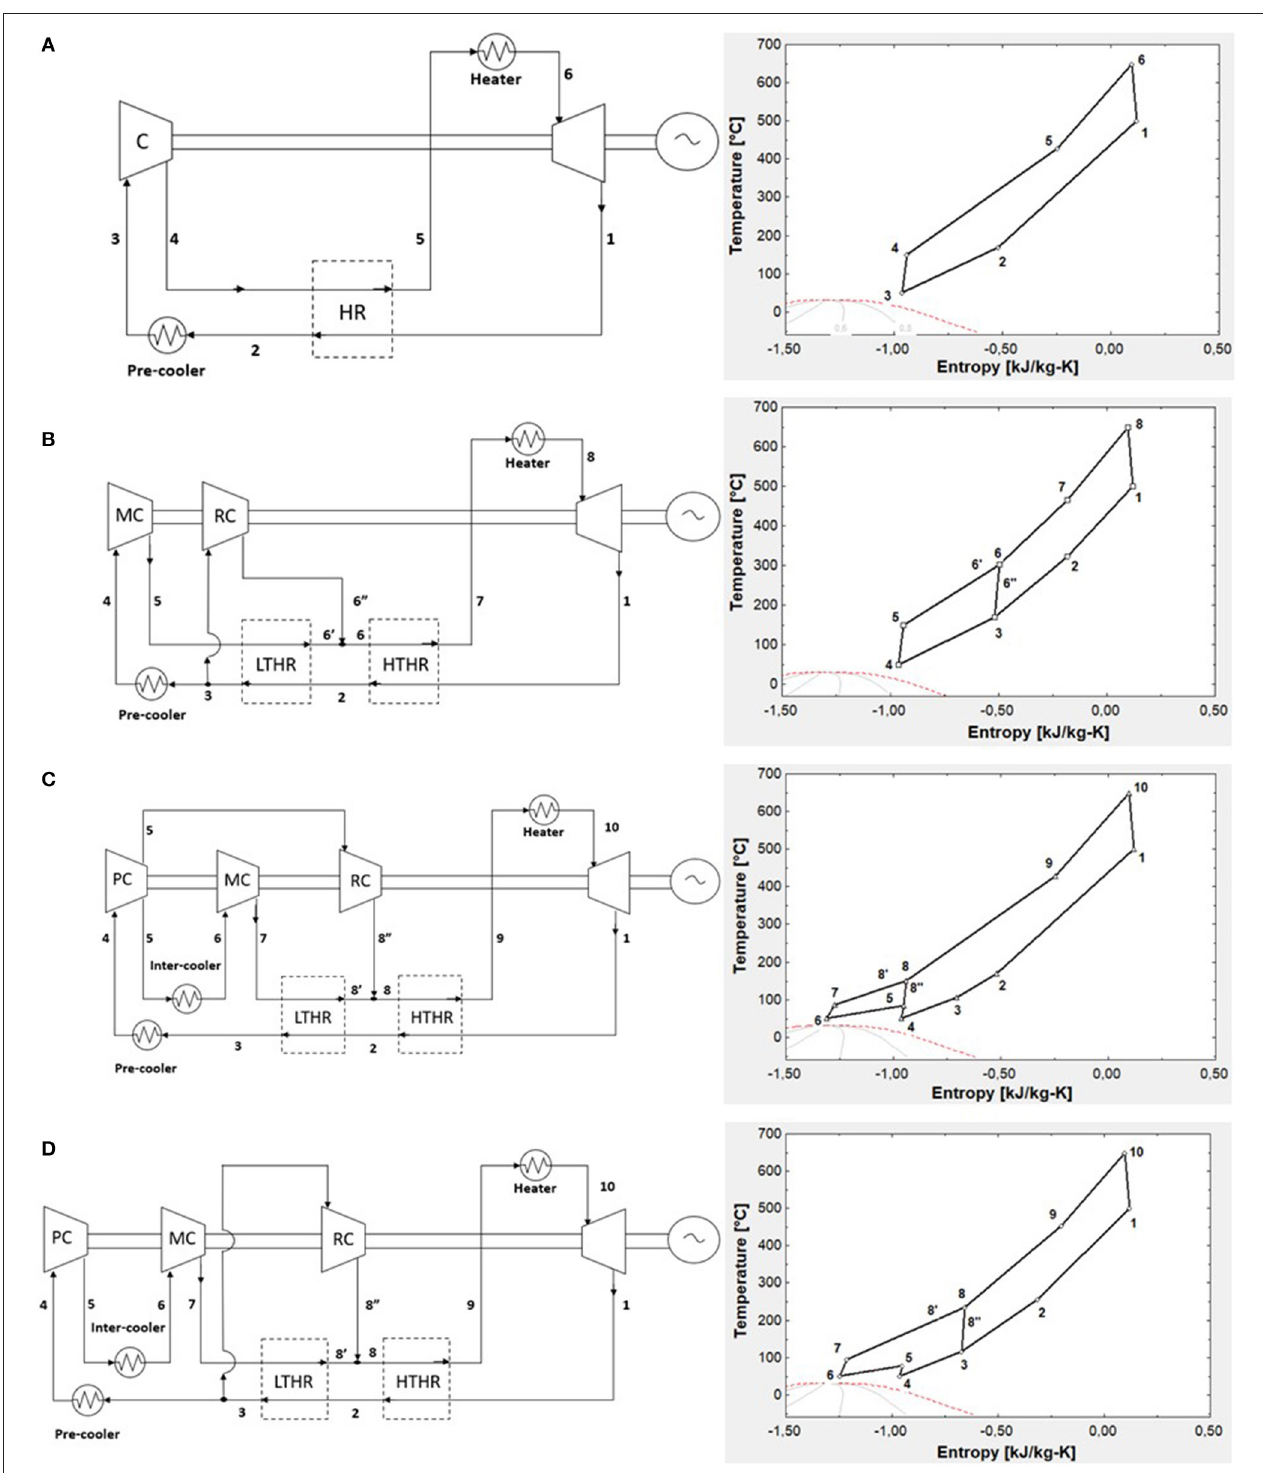
FIGURE 2 | (A) Simple regeneration s-CO 2 Brayton cycle; (B) recompression s-CO 2 Brayton cycle; (C) partial cooling s-CO 2 Brayton cycle; and (D) intercooling s-CO 2 Brayton cycle. The corresponding T–s diagrams are shown on the right side.